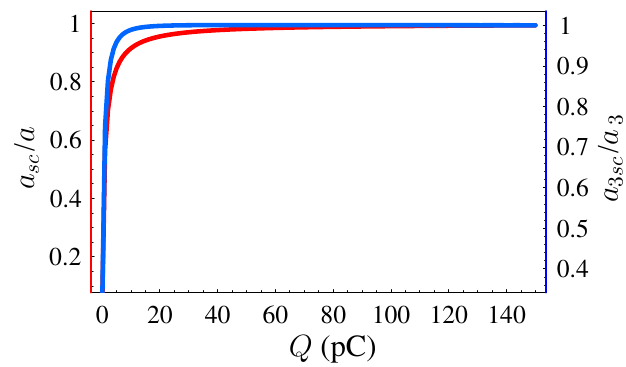
(cid:7) 1 and (ii) space-charge =a sc i ’ 1 . =a sc i